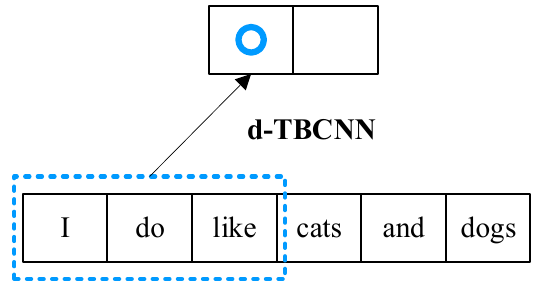
Figure 3. Schematic diagram of dependency convolution network.